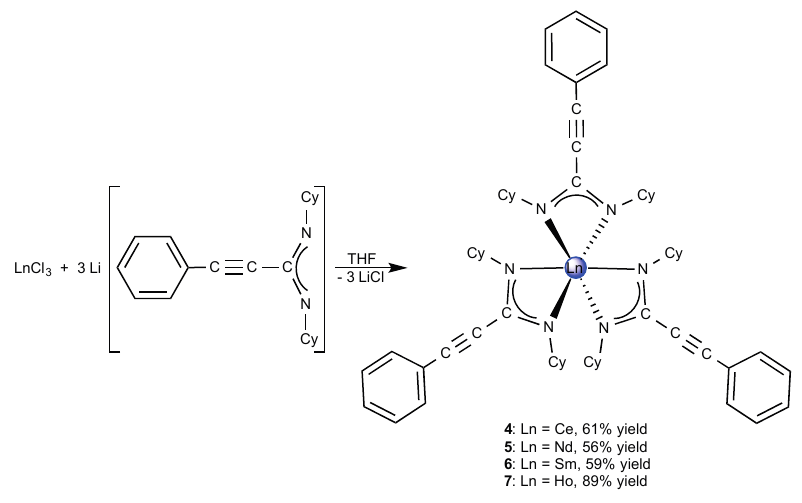
A series of homoleptic lanthanide(III)-tris(propiolamidinates) were prepared in a straightforward manner according to Scheme 3. The reaction of anhydrous LnCl 3 (Ln = Ce, Nd, Sm or Ho) with 2 in a 1:3 molar ratio using THF as solvent afforded a series of new homoleptic lanthanide tris(propiolamidinate) complexes, [Ph–C ≡ C–C(NCy) 2 ] 3 Ln (Ln = Ce ( 4 ), Nd ( 5 ), Sm ( 6 ), Ho ( 7 )). The products were isolated in moderate to high yields ( 4 : 61%, 5 : 56%, 6 : 59%, 7 : 89%) yields as unsolvated complexes in the form of brightly colored crystals ( 4 : orange, 5 : pale green, 6 : yellow, 7 : bright yellow).